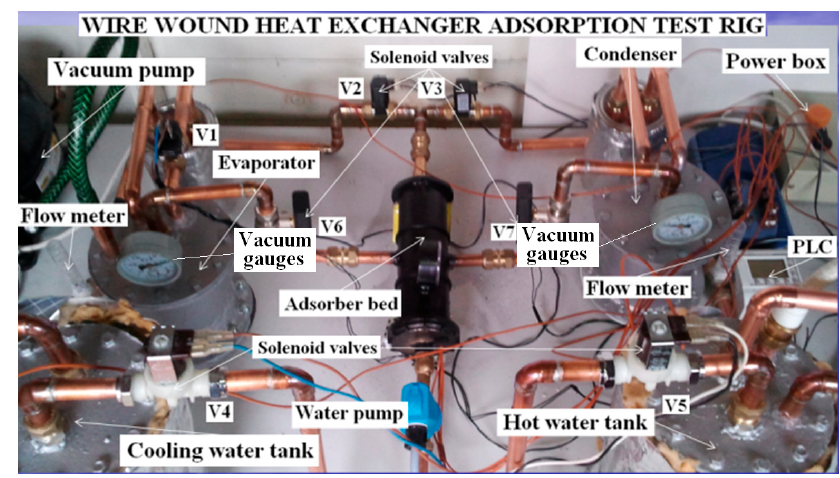
Figure 5. The adsorption bed test rig.